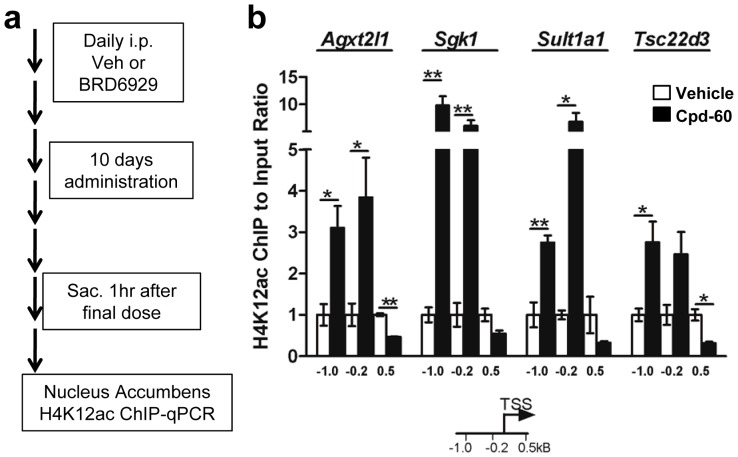
Chromatin immunoprecipitation (ChIP) of nucleus accumbens from Cpd-60 treated mice.(a) Schematic of experimental design with 10-day administration of Cpd-60 (45 mg/kg, i.p.). (b) Chromatin was immunoprecipitated with an anti-histone H4K12ac-antibody followed by qPCR targeting regions 1.0 or 0.2 kB upstream or 0.5 kB downstream from the transcription start site (TSS). Transcripts upregulated by Cpd-60 treatment had increased histone acetylation at promoter regions upstream, but not downstream, of the TSS in Cpd-60 treated tissue compared to vehicle. *p<0.05, **p<0.01, t-test of Cpd-60 versus vehicle.